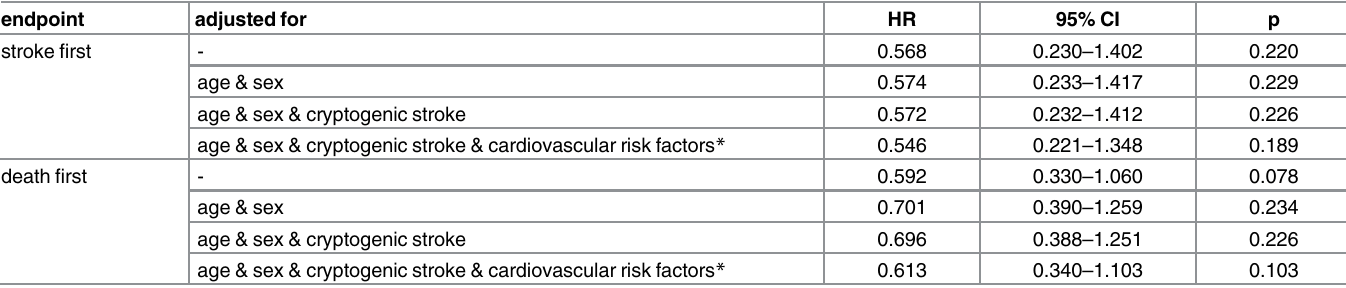
Table 4. Multivariate analysis for all included